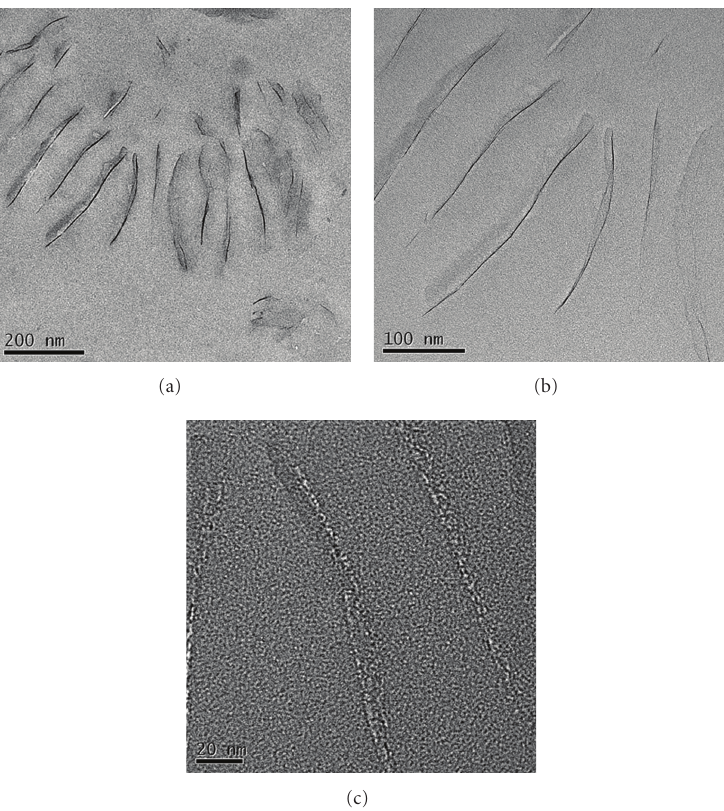
Figure 12: TEM images of epoxy/clay nanocomposites via high-speed mixing method at di ff erent